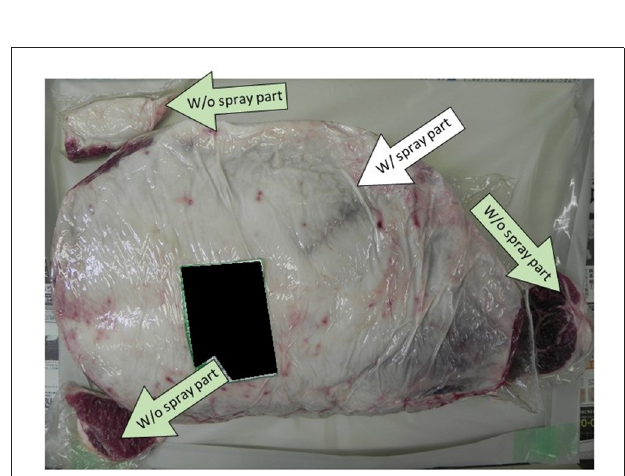
FIGURE 5 | Showing the positions where the spray method with calcium hydroxide–ethanol–lactate (CEL) disinfectant was applied on the beef